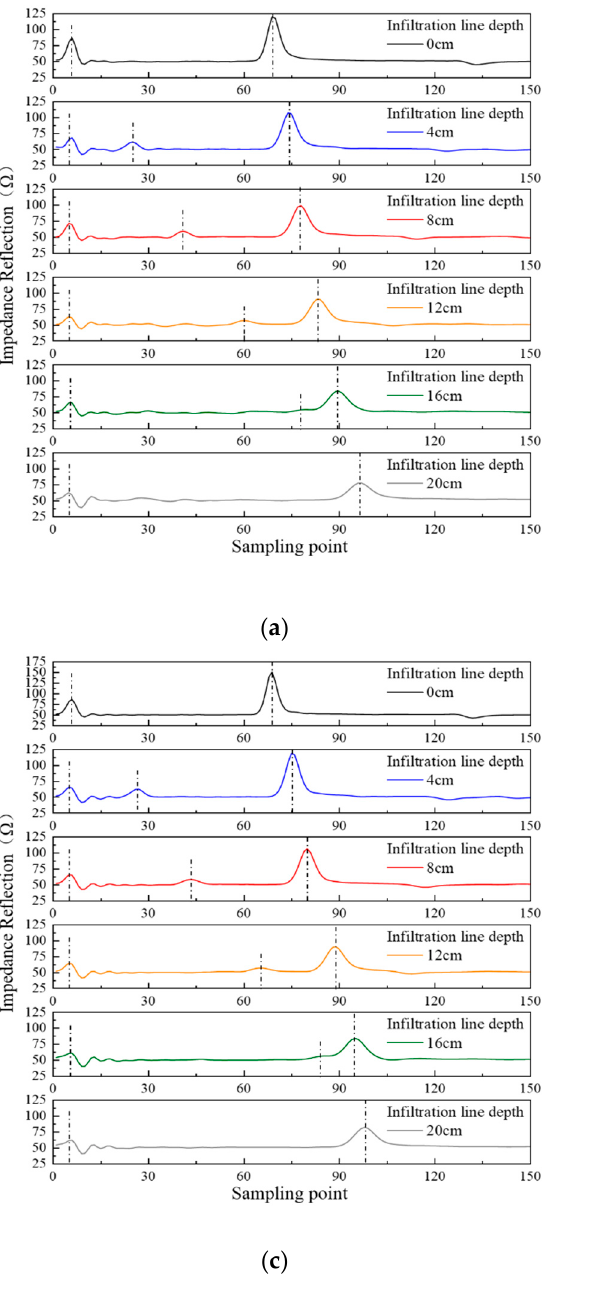
Figure 4. Single-wave measurements of different infiltration lines for four types of soil: ( a ) Shaanxi Lou soil; ( b ) clay loam; ( c ) loess; ( d ) black soil.